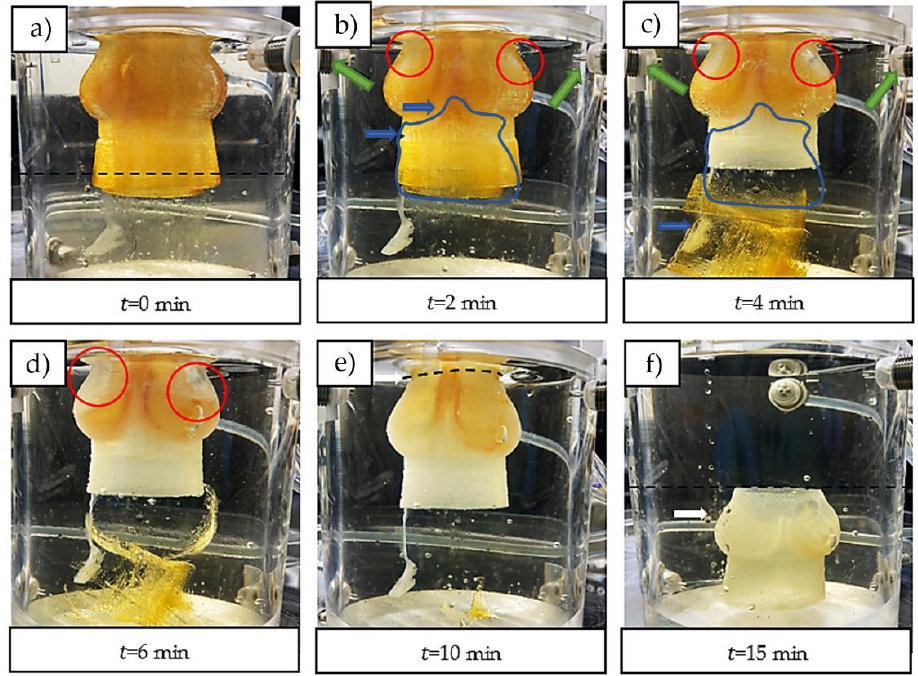
Figure 3. Dissolution process of the sugar glass mold and final gelation step of the scaffold. ( a ) t = 0 min, fresh CaCl 2 solution above the dashed line and dissolved sugar at the bottom (yellowish liquid). ( b ) t = 2 min, the inlet jets of fresh CaCl 2 solution (green arrows) made holes in the sugar glass mold (red circles). The blue arrows and blue outlined area show the dissolving inner structures that are falling to the bottom. ( c ) Dissolution of the mold at t = 4 min. ( d ) Dissolution of the mold at t = 6 min. ( e ) t = 10 min, the scaffold was manually cut with a scalpel at the site represented by the dotted line. ( f ) t = 15 min, the dissolution and gelation processes were completed.